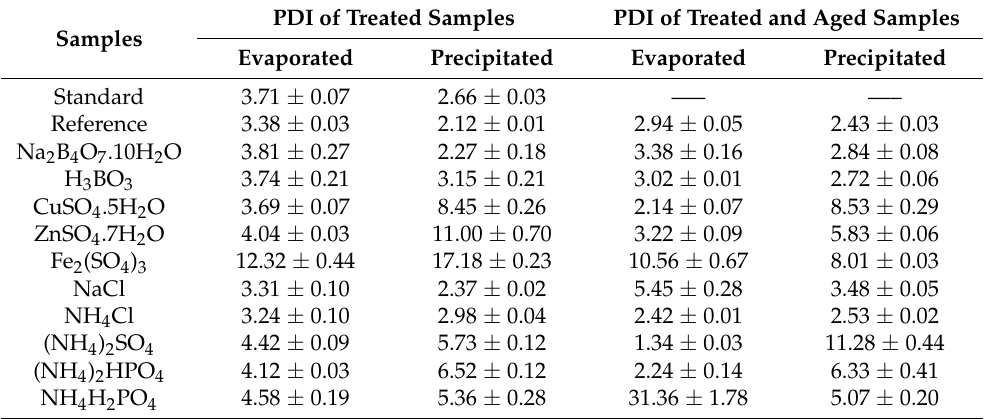
Table 2. Polydispersity index (PDI = Mw/Mn) for chemically treated and aged cellulose samples (mean ± SD). PDI of Treated Samples PDI of Treated and Aged Samples Samples Evaporated Precipitated Evaporated Precipitated Standard —–